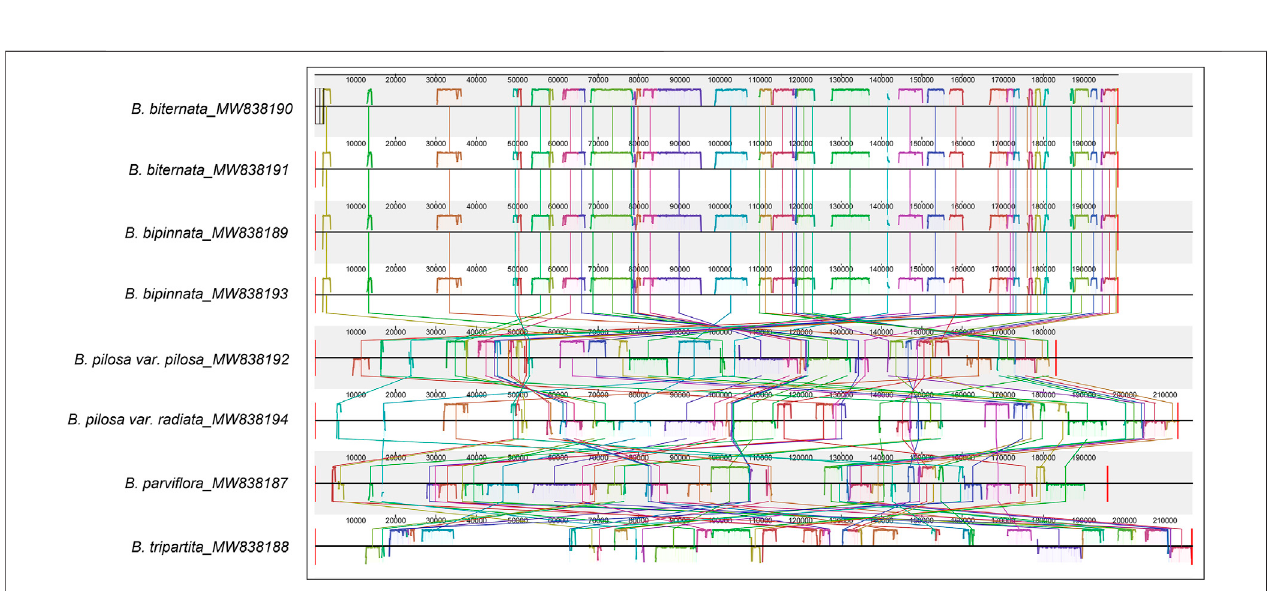
FIGURE 6 | Collinearity analysis of the chloroplast genomes of Bidens species. Local collinear blocks are represented by blocks of the same colour connected by lines.